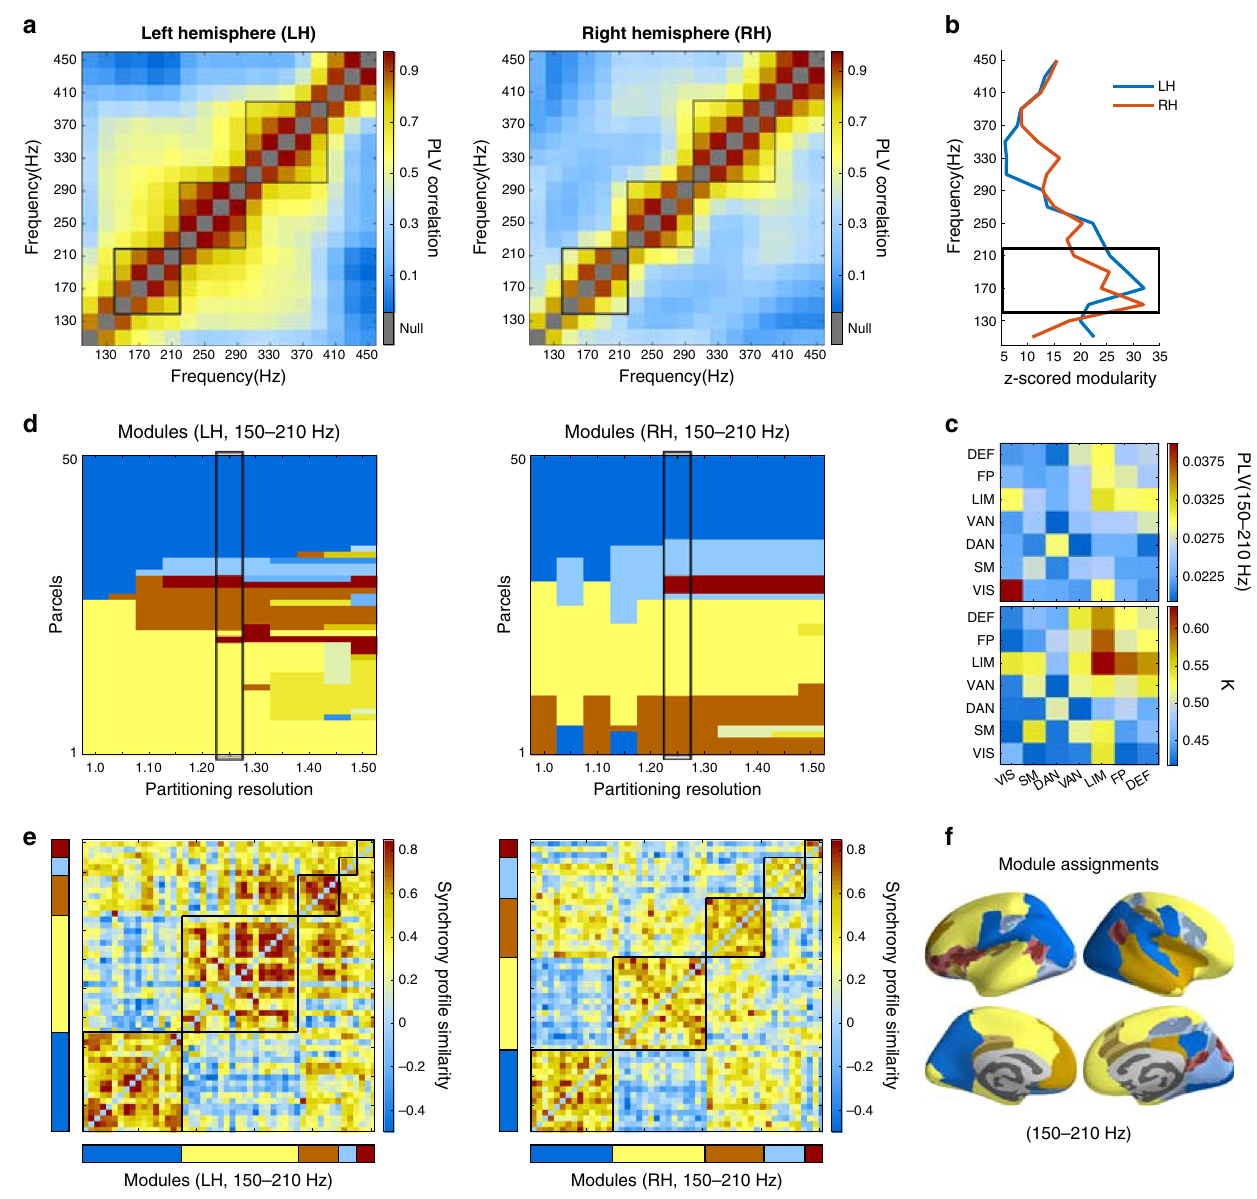
Fig. 4 Neuroanatomical localization and community structures in HFO synchrony networks. a Topological similarity between narrow-band PLV connectomes in Schaefer 100-parcel parcellation. b Mean normalized modularity (z-score against degree-distribution matched surrogate networks) assessed with Leiden community detection (see Supplementary Fig. 5). c Mean contact-pair PLV and fractions of signi fi cants ( K ) between the seven functional systems of Yeo parcellation in the 150 – 210 Hz frequency band. d Community identities of cortical parcels as a function of the resolution parameter, γ , of the Leiden community detection algorithm. e Communities at γ = 1.25 (black squares) in sorted synchronization similarity matrices. f Communities of ( e ) illustrated on in fl ated cortical surfaces (parcels with signi fi cantly stable community assignment rendered opaque (one-tail test, p < 0.05, parcel module-allocation stability, Supplementary Methods)). Module assignments to 22% left and 14% right-hemispheric parcels were unstable one-tail test, ( p > 0.05, parcel module-allocation stability, Supplementary Methods) and rendered